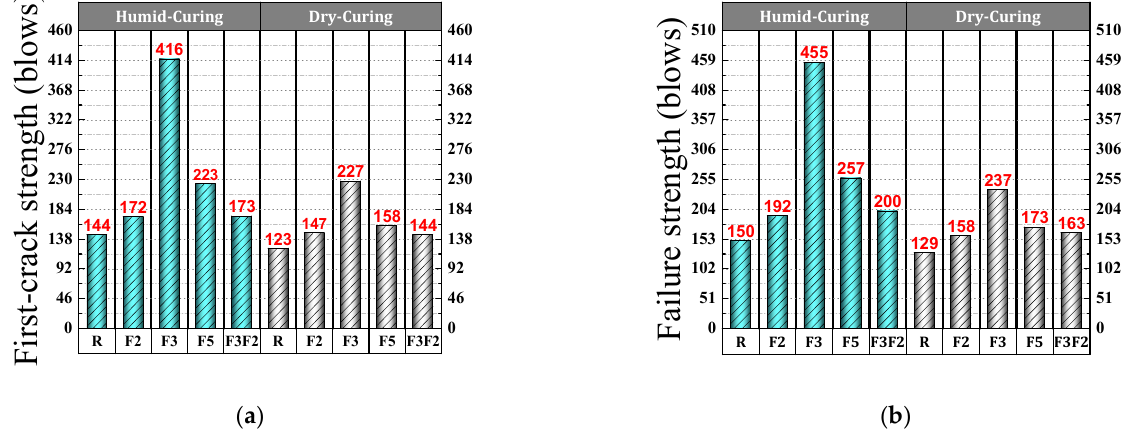
Figure 11. Average blows for concrete discs: ( a ) first-crack strength; ( b ) failure strength. The results given in Table 8 show that high-strength concrete containing 5 cm crimped steel fibers can withstand a higher number of average blows than concrete containing 2 cm crimped steel fibers. This shows the positive effect that fibers with a longer length- to-diameter ratio have on impact strength. Fiber shape, however, also plays a role. The hooked fibers increased the impact strength of the high-strength concrete better than the crimped fibers did, even with a stronger length-to-diameter ratio. The trend observed for the performance of steel fibers in a humid environment is similar to that for curing in dry environments. In dry curing conditions, an average of 123 blows was required to create the first crack in the high-strength control concrete, which increased to 147, 227, 158, and 144 in the fiber-reinforced concretes F2, F3, F5, and F2F3, respectively (Figure 11a). For the mixtures, a 95% confidence interval was obtained on the average resistance of the first crack, which includes the lower and upper bounds (Table 8). This range indicates that there is a 95% chance that the true first-crack resistance is within this range [21,26]. The coefficients of the variation of the first-crack impact strength for mixtures R, F2, F3, F5, and F2F3 in a humid environment were 27%, 33%, 77%, 36%, and 37%, respectively. The corresponding values for dry curing conditions were 29%, 32%, 88%, 41% and 44%, respectively. Thus, the impact strength data shows more dispersion for dry-cured concrete than those cured in humid conditions. As stated, p -values of less than 0.05, obtained by the Kolmogorov–Smirnov test, indicate that the data are not normally distributed. The normal probability shapes and histograms for different mixtures cured in humid conditions are plotted in Figures 12–15. Figures 16–19 show the corresponding values for dry curing conditions.